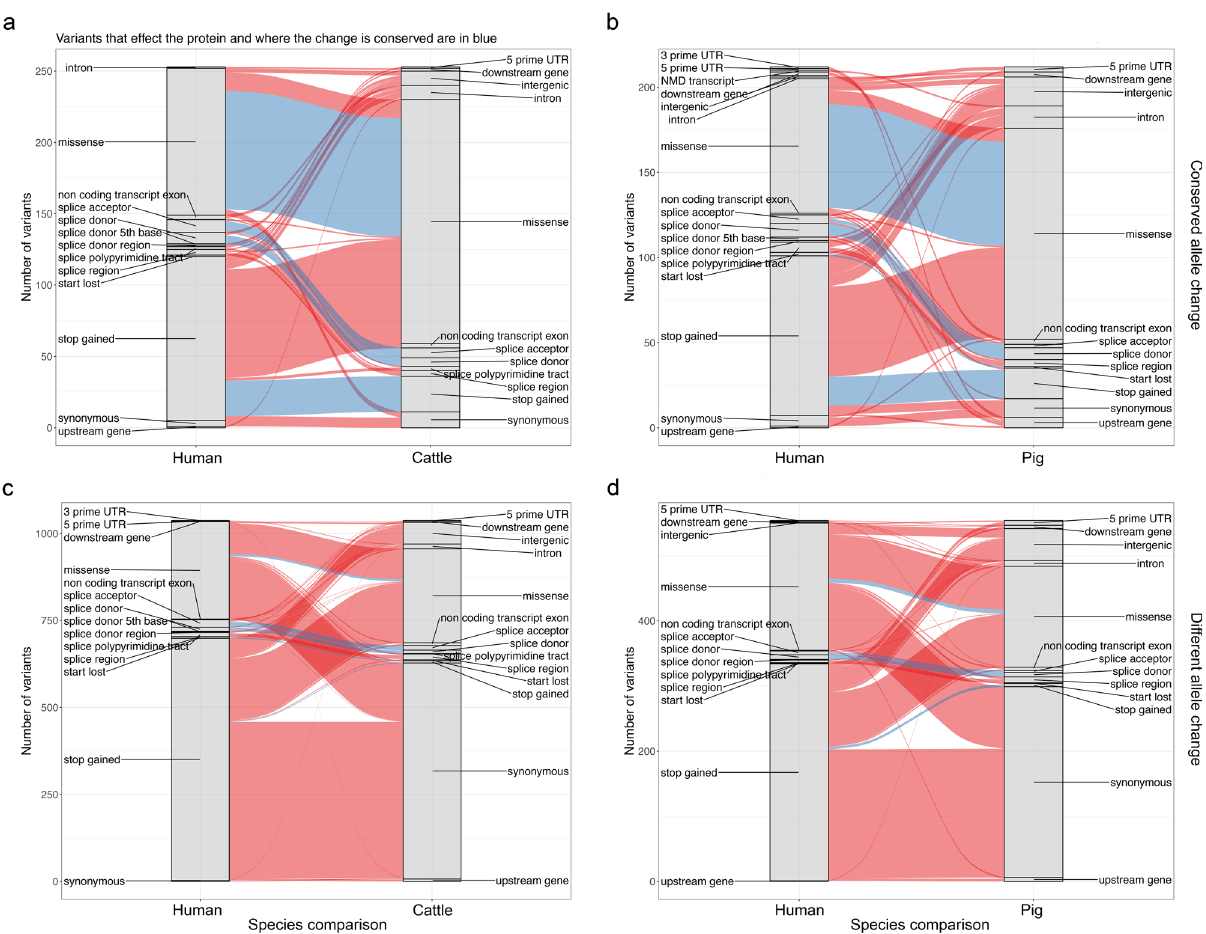
Fig. 4 Conservation of impacts of orthologues of Clinvar variants. Each plot shows the consequence of variants in humans (on the left) and the consequence of variants found at the same position in the pig or cattle genome on the right. The ribbons connect sets of variants, with the width of each ribbon indicating the number of variant pairs with the given combination of consequences across the two species. Ribbons in blue indicate where variants have potentially conserved impacts on the protein across species. a The conservation of impact of genic orthologous variants across human and cattle where variants show the same allele change. b The same as ( a ) but for human-pig orthologous variants. c Conservation of impact of variants across human and cattle where their locations are orthologous but they show different allele changes. d The same as ( c ) but for human-pig orthologous variants. The data underlying this fi gure can be found in Supplementary Data